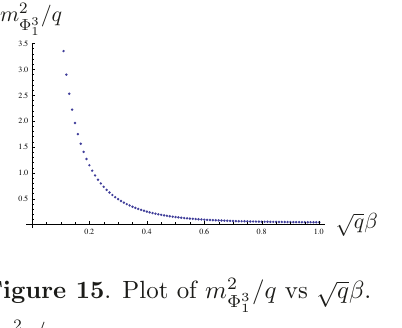
Figure 15 . Plot of m 2